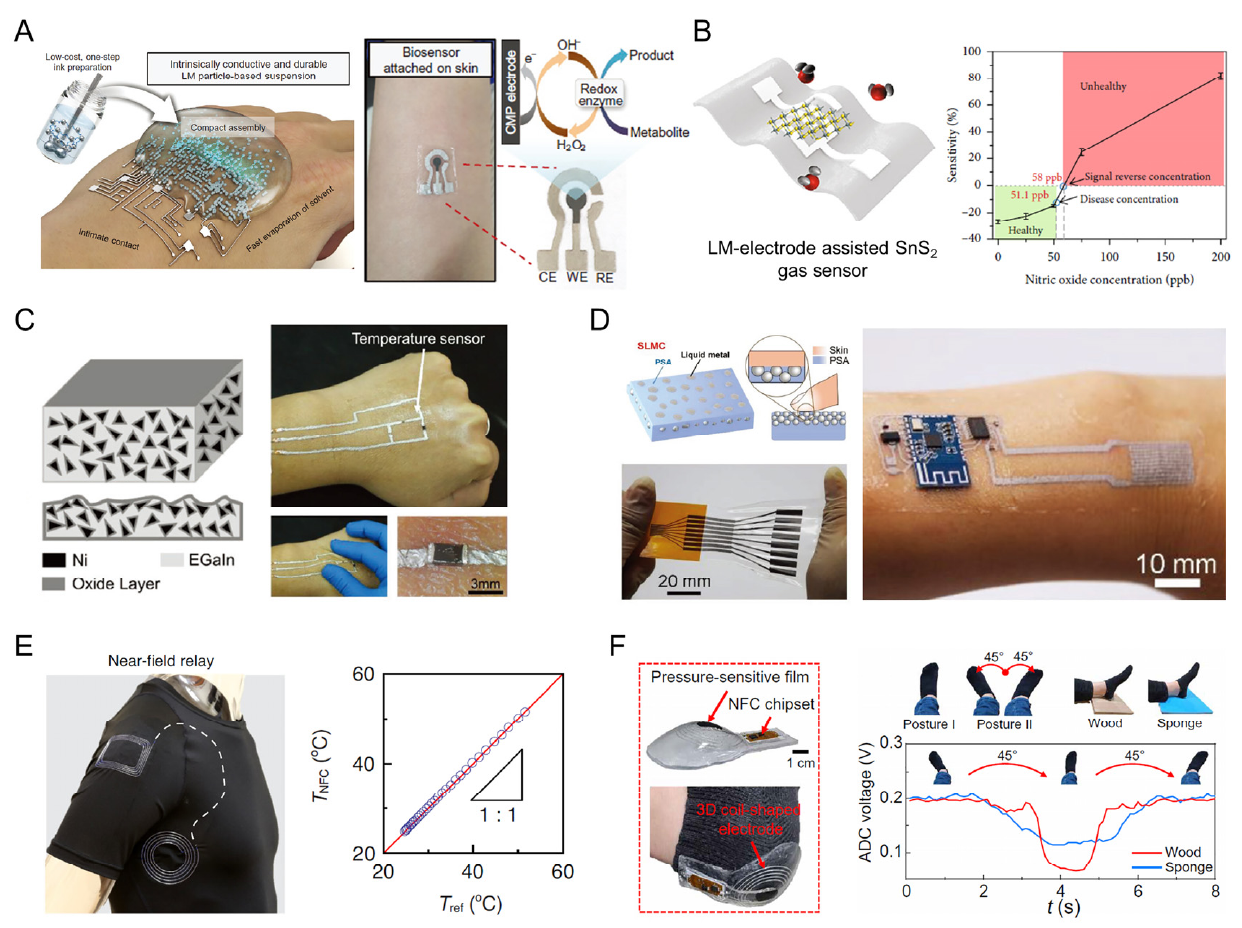
Figure 10. The multifunctional epidermal healthcare biosensors that are enabled with LM-based conductors. ( A ) Schematic of Pt-decorated CNT-attached LM particles (CMP) for on-skin e-tattoo ( left ). The photograph of CMP-based biosensor for sweat chemistry [102]. Copyright: (2022) WILEY- VCH. ( B ) Schematic illustration of LM electrode-assisted gas sensor with SnS 2 ( left ). The sensitivity of gas sensors regarding NO gas concentrations [103]. Copyright: (2021) AAAS. ( C ) Schematic